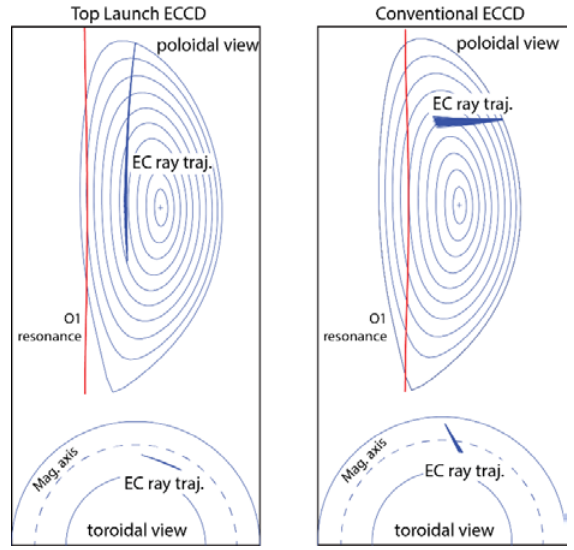
Figure 2:Typical ray trajectory comparison between top launch ECCD and conventional ECCD in poloidal and toroidal views. (from CFETR study described in Section